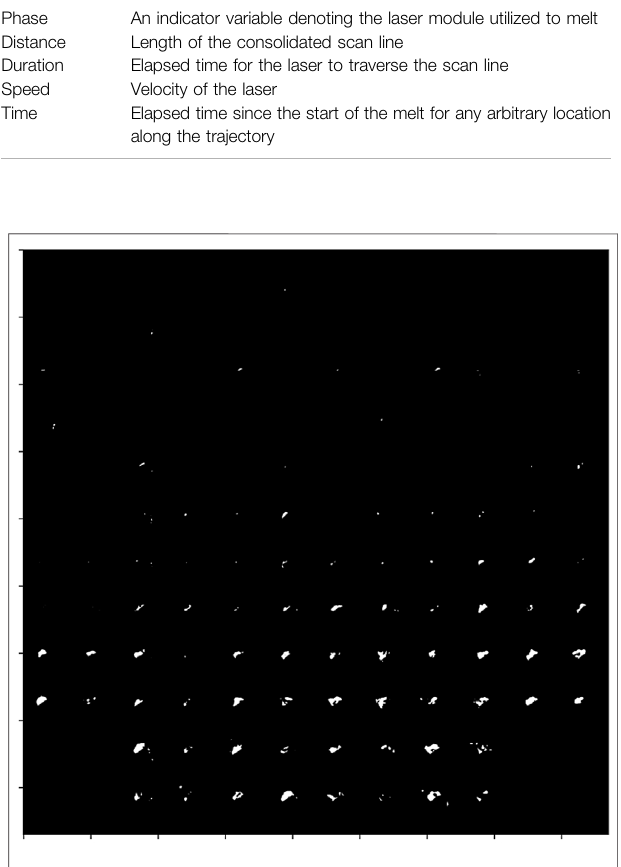
TABLE 2 | Description of trajectory data used as the basis of spatial mapping of the in-situ process data and to detect defects for this analysis. Variable name